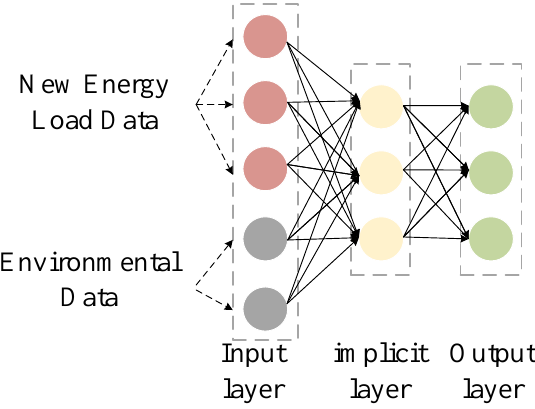
Figure 1. BP neural network topology diagram.